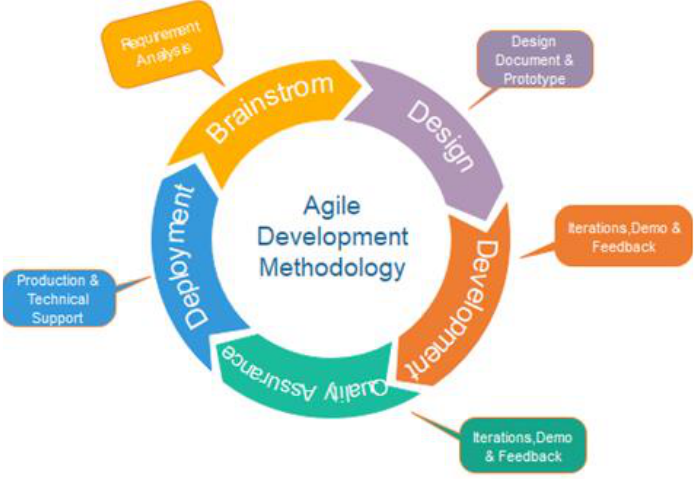
Figure 3. Agile iterative approach for smart classroom teaching strategy development.